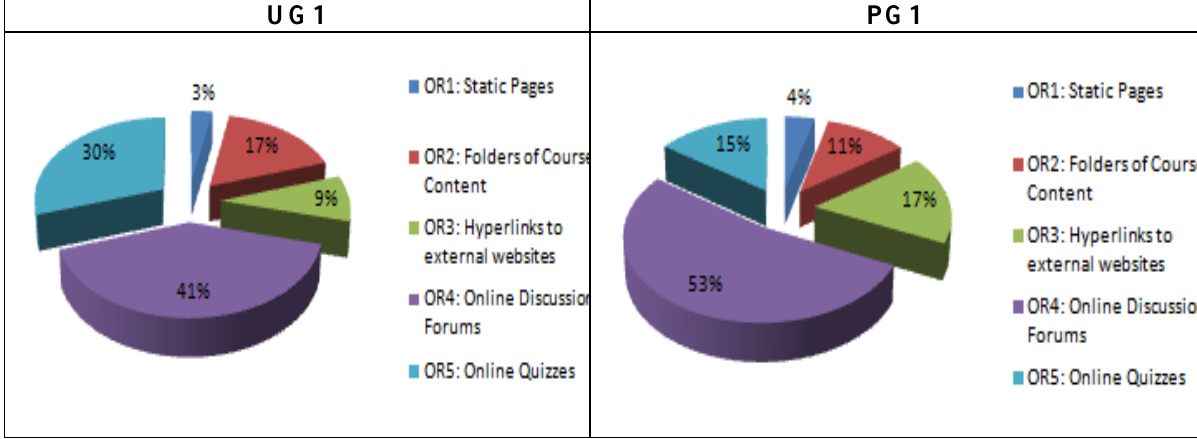
Figure 3: Distribution of Use to the Various Online Resources in WawasanLearn UG1